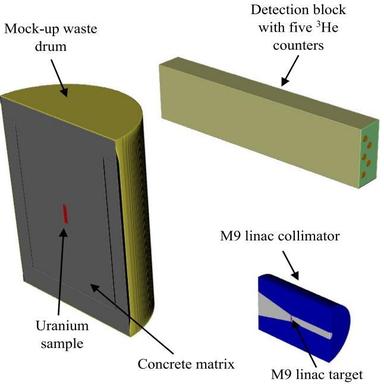
Virtual concrete filled mock-up drum case.